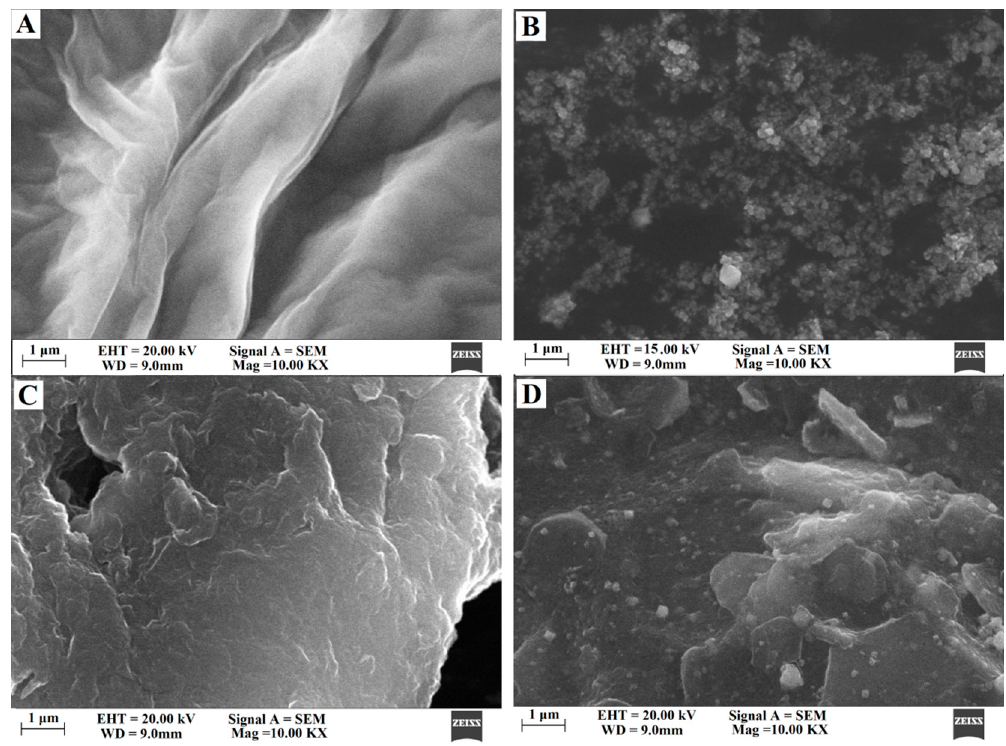
Figure 2. SEM images of ( A ) GO, ( B ) Cu 2 O nanoparticles, ( C ) ERGO, and ( D ) Cu 2 O–ERGO composites.